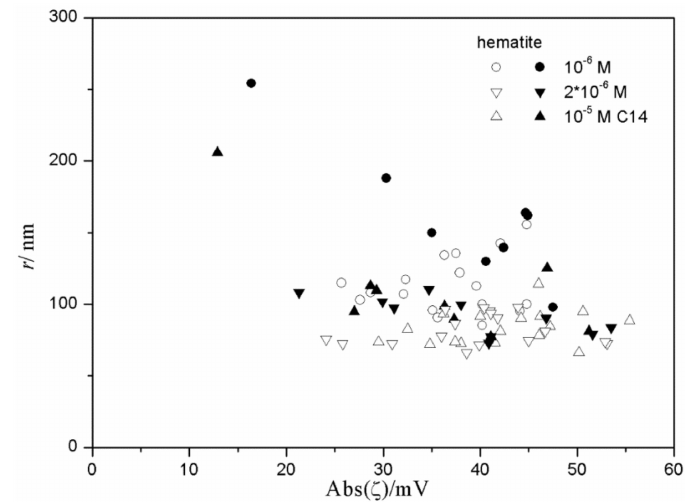
Figure 9. The particle size as a function of | ζ | in fresh (white points) and aged (black points) dispersions of hematite in the presence of sodium